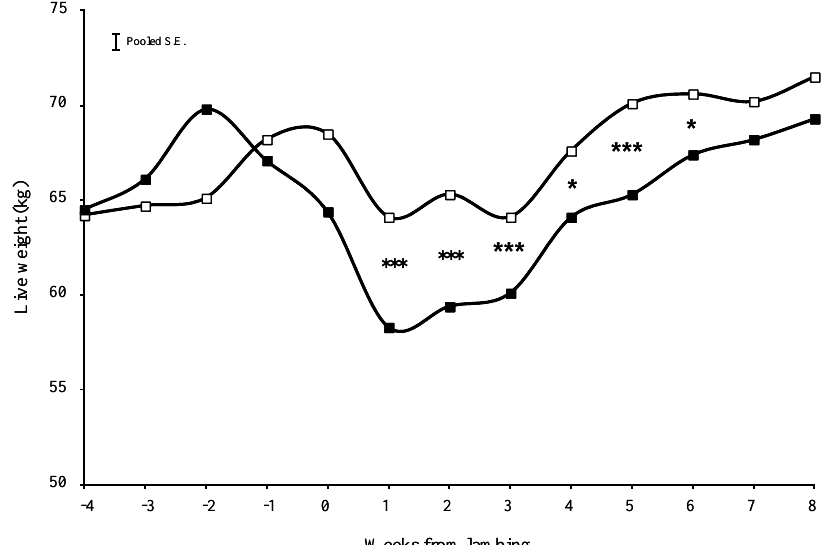
Figure 2. Live weight changes in Dorper ewes fed a control diet (Control = □ ) or supplemented with Yerba Mate (Yerba Mate = ■ ). Values are expressed as means  SE **